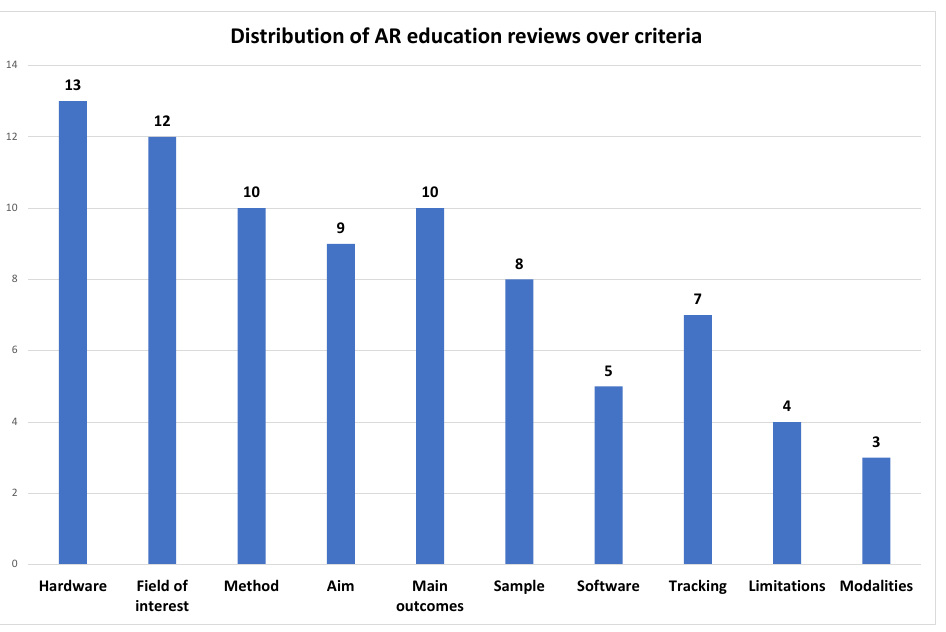
Figure 6. Distribution of AR education reviews over criteria (min: 3–max: